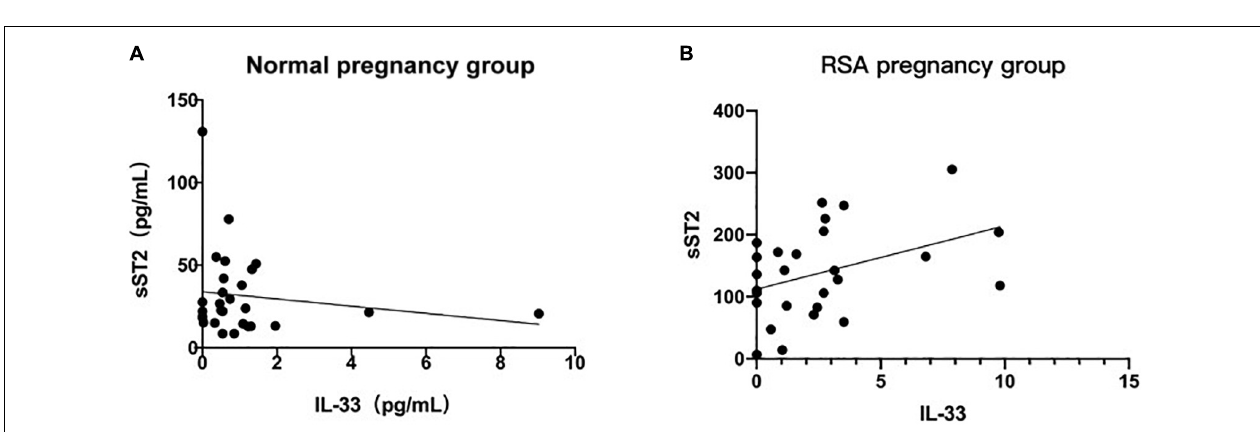
FIGURE 4 | Relationship between maternal serum IL-33 and ST2 level and number of miscarriage. (A) Correlation between serum IL-33 and number of miscarriage. (B) Correlation between serum soluble ST2 and number of miscarriage.